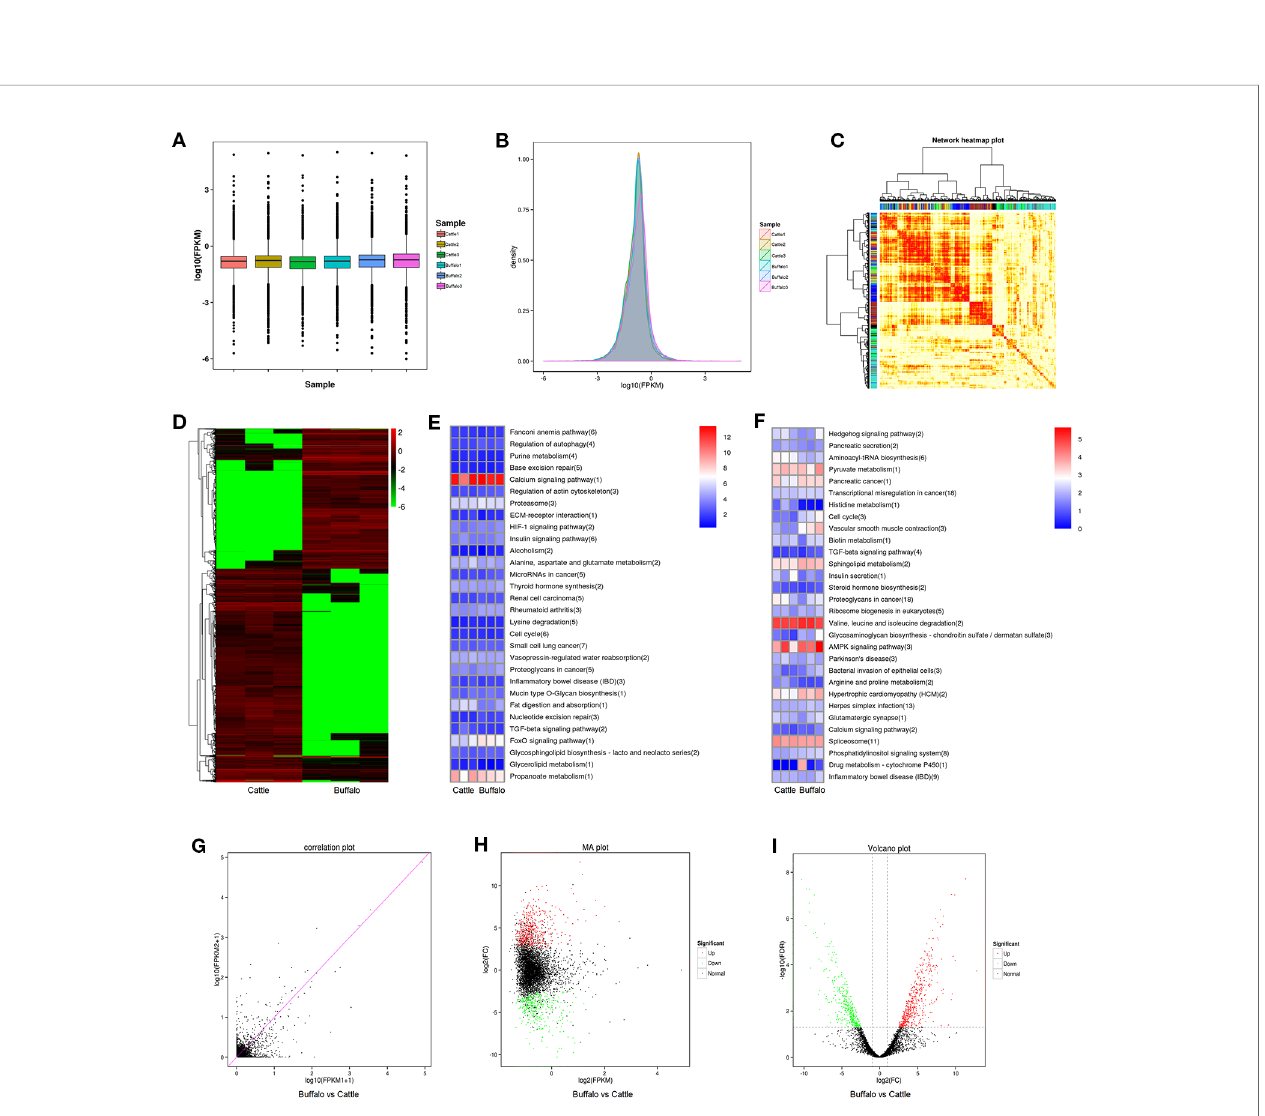
FIGURE 3 | Differentially expressed lncRNAs in buffalo and cattle skeletal muscle. (A , B) The expression levels of lncRNAs, plotted as fragments per kilobase of exon per million fragments mapped (FPKM). (C) Weighted gene coexpression network analysis of lncRNAs in buffalo and cattle muscle sample. (D) Heatmap of differentially expressed lncRNAs in buffalo and cattle muscle tissue. (E , F) The top 30 enriched KEGG pathways by cis (E) and trans (F) regulation. (G – I) Scatter plot, MA interactive maps and volcano plot showing the correlation between abundances of individual lncRNAs in buffalo and cattle muscle